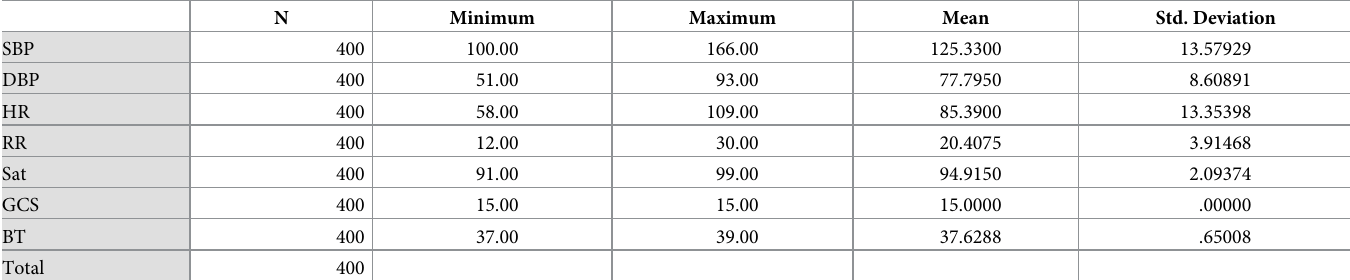
Table 2. Patients’ vital